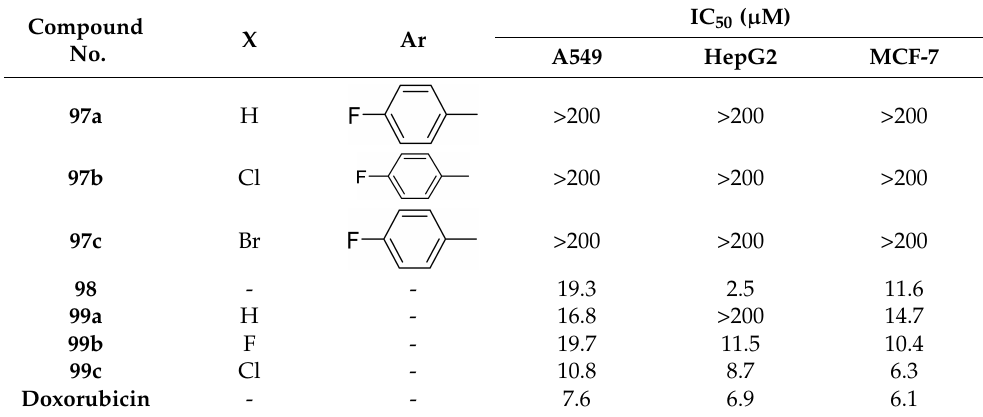
Figure 94. Structure of isatin-pyridine derivatives [ 97 ( a – c ), 98 , and 99 ( a – c )]. Table 84. In vitro cytotoxic activities of isatin-pyridine hybrid compounds [ 97 ( a – c ), 98 , 99 ( a – c )]. Compound